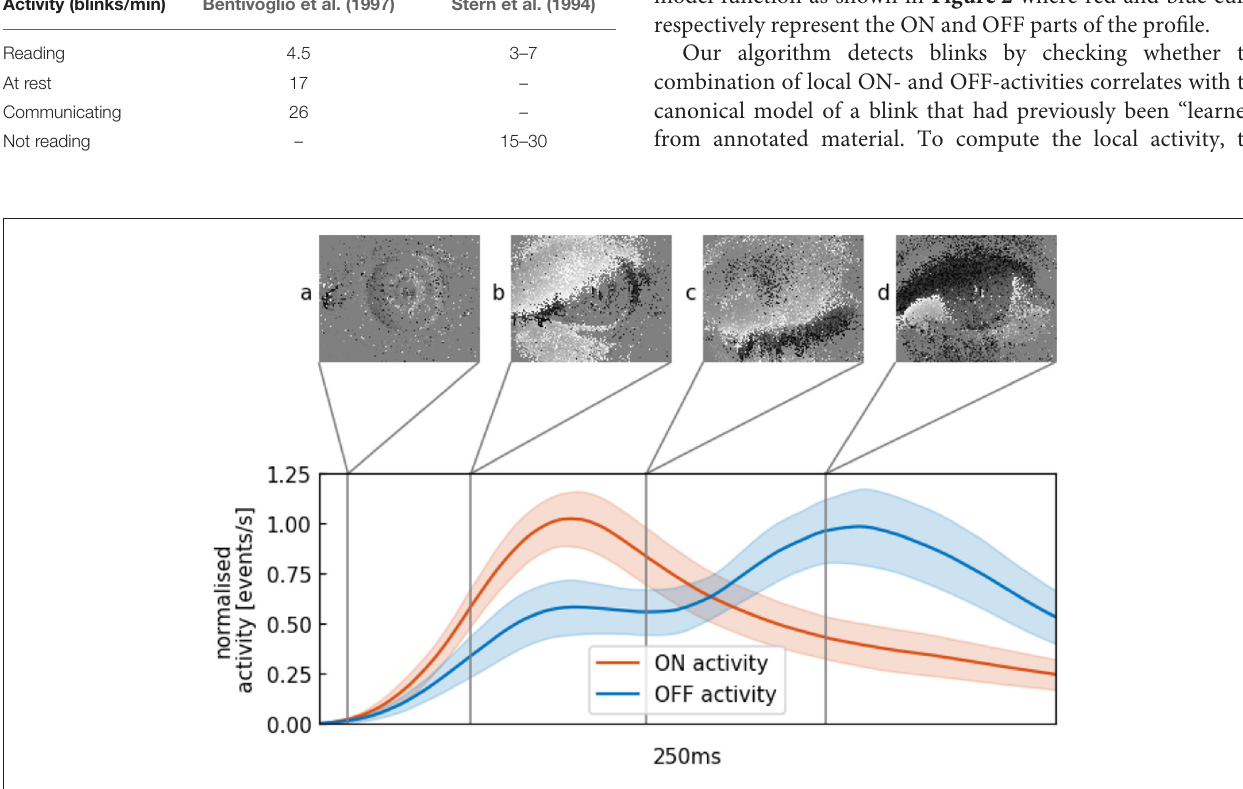
Frontiers in Neuroscience |